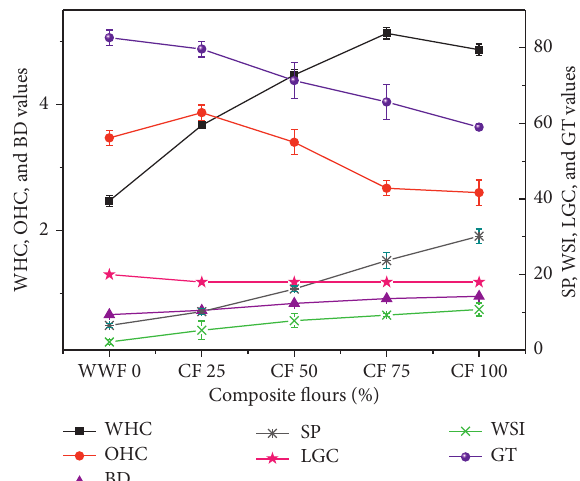
Figure 1: Effect of cladode flour incorporation on functional properties. CF � cladode flour; WWF � whole-wheat flour; WHC � water-holding capacity (%); OHC � oil-holding capacity (%); SP � swelling power (mL); BD � bulk density (g/cm 3 ); LGC � least gelation concentration (%); WSI � water solubility index (g/100g); GT � gelatinization temperature ( °